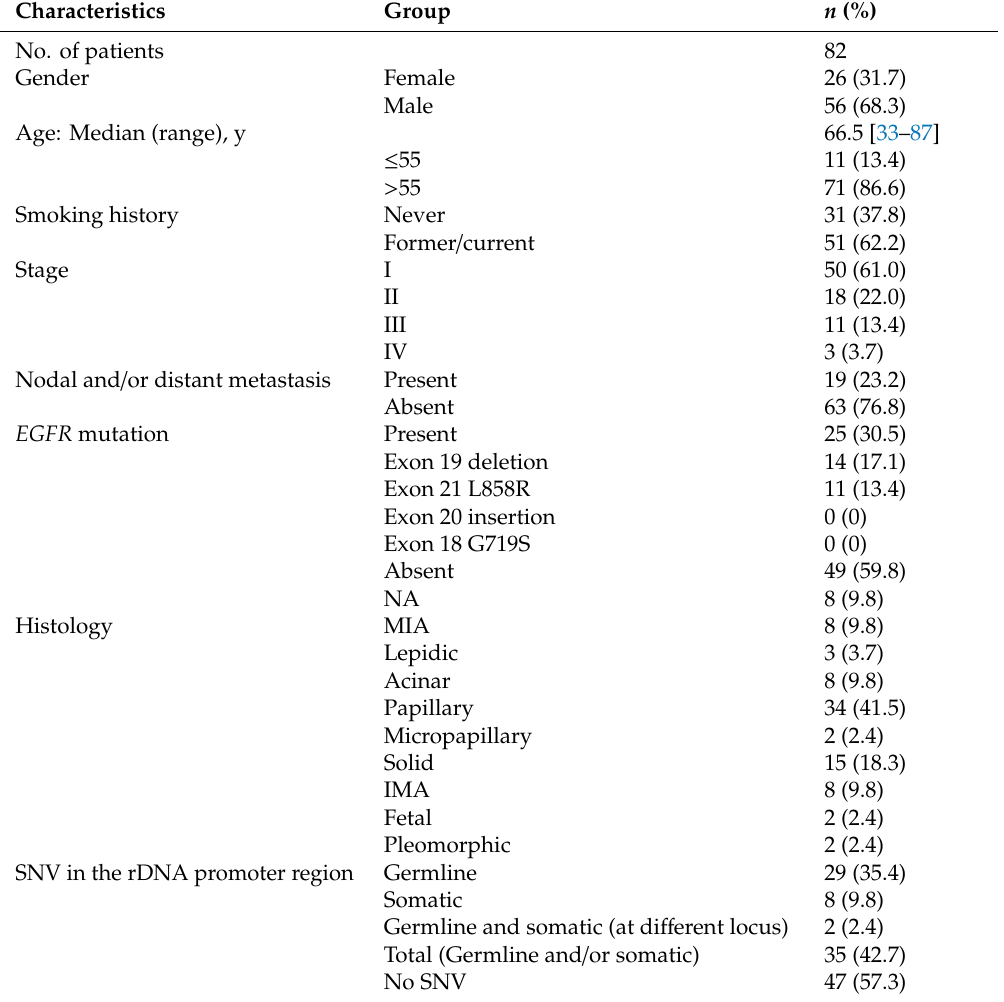
Table 2. Patient